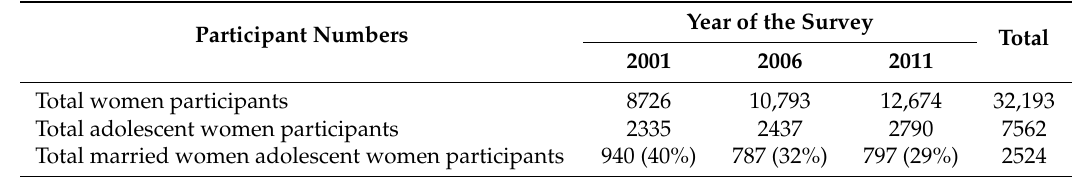
Table 1. Number of married adolescent women from National Demographic and Household Survey; data from 2001, 2006 and